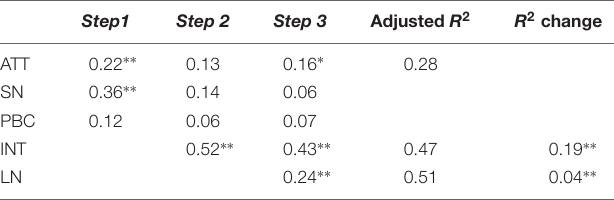
TABLE 7 | Hierarchical regression analysis predicting self-reported participation in household waste recycling on sample 2 ( N =